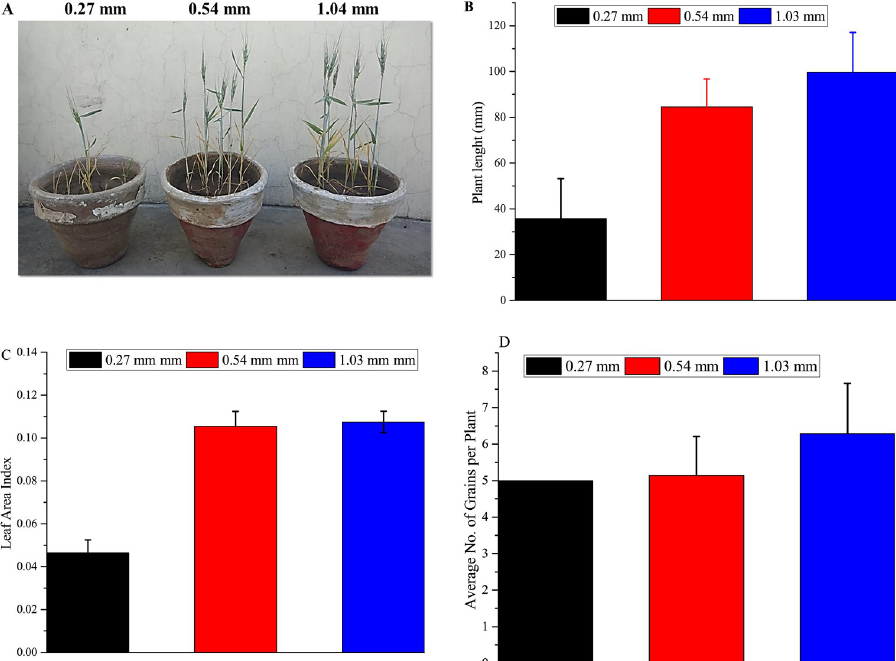
Fig 9. Effect of the SRF thickness on the plant growth performance. A) Photographic visuals of Wheat plant; B) plant length; C) Leaf Area Index; D) Average number of grains per plant.